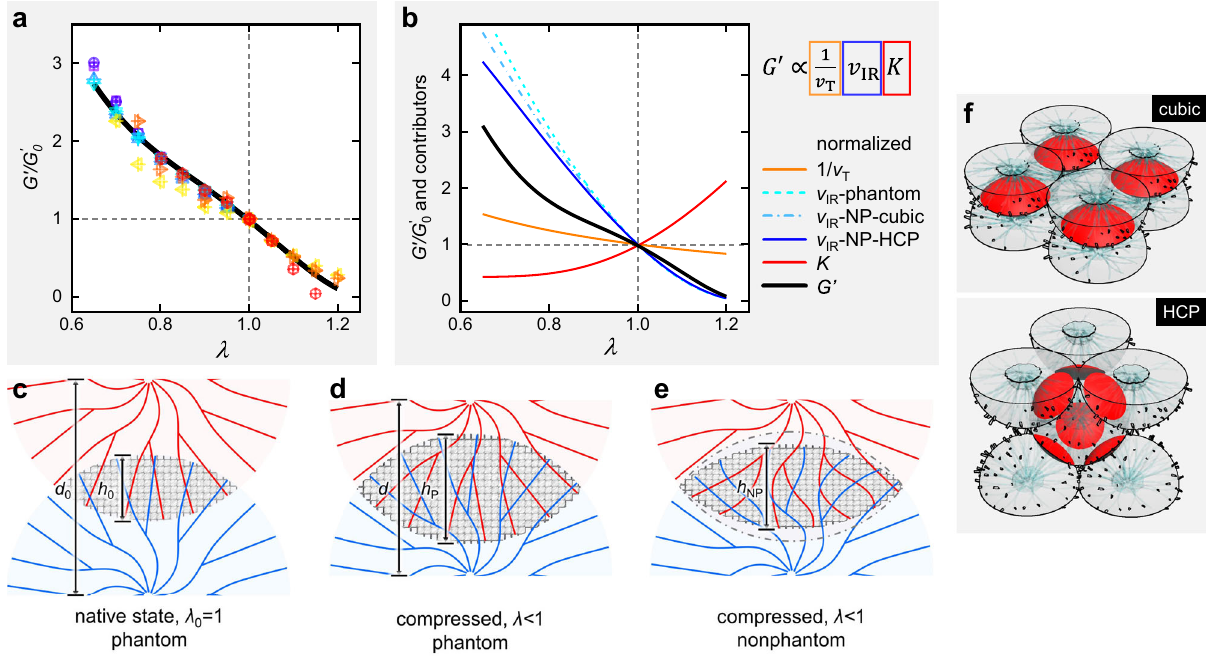
of astral gels as a function of stretch ratio λ , where the experimental data Fig. 5 A master curve and a minimal model. a Normalized shear elasticity G 0 = G 0 0 points from Fig. 3d, e collapse to a single master curve. The black line is a global fi tting with d 0 = 0.79 R and T = 0.15. b Dependence of normalized elasticity and its contributors on stretch ratio, as predicted by the proposed minimal model with input parameters d 0 = 0.8 R and T = 0.2. c – e Schematic sketches of two axially stacked asters under compression, in which the interpenetration regions in phantom or nonphantom states are highlighted by gray grids. Note that the interlaced ribbons are undisturbed in phantom limit ( c , d ) but buckled in the nonphantom condition ( e ). f Cubic packing and hexagonal close packing (HCP) of monodispersed asters, where the interpenetration regions are stressed in